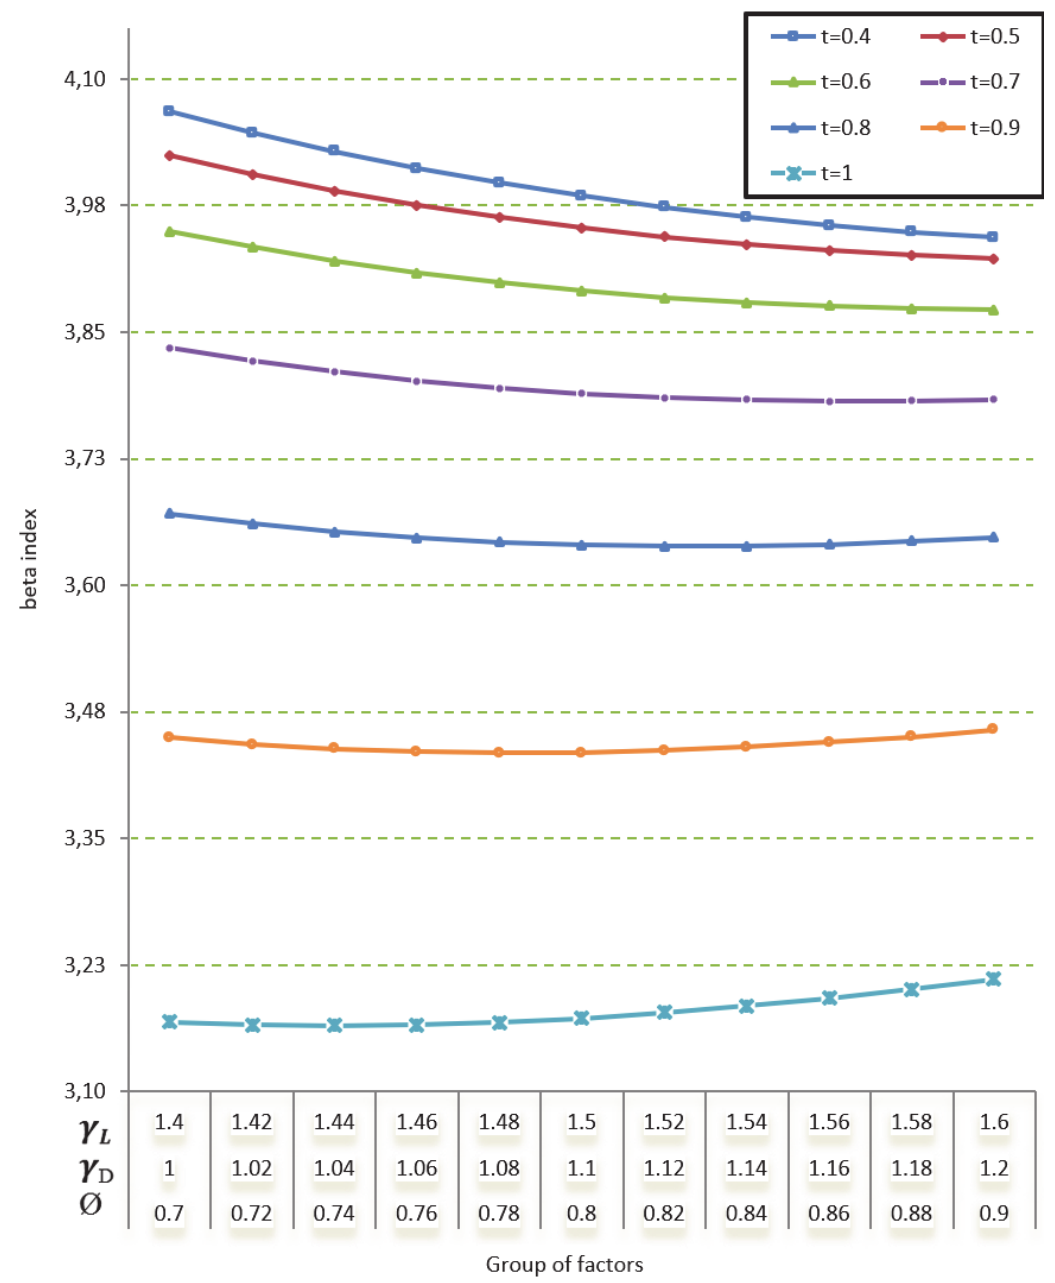
Figure 9: Prediction of load and resistance factors for the L section beam in combined